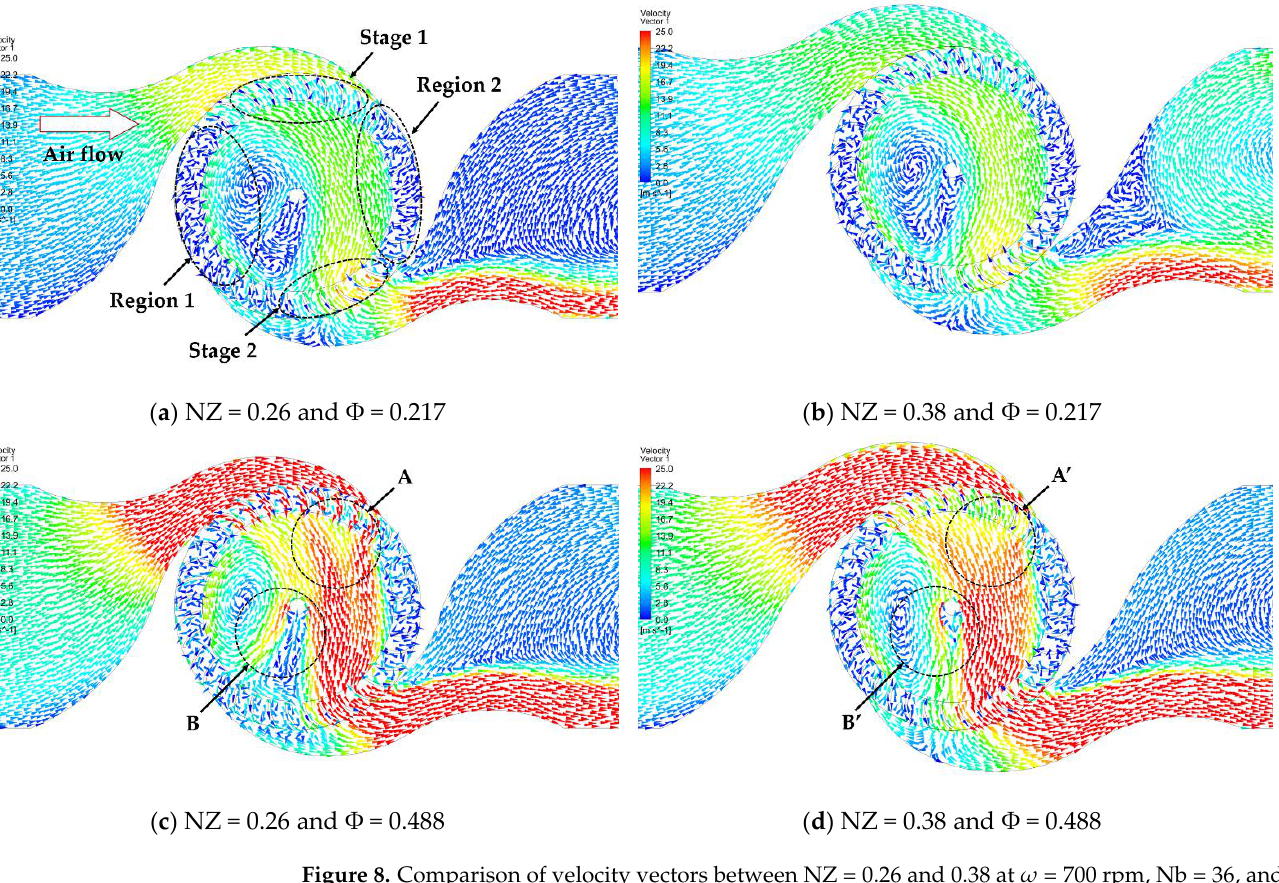
Figure 7. Effect of nozzle throat width on the turbine performance with 700 rpm and 3 mm blade thickness.